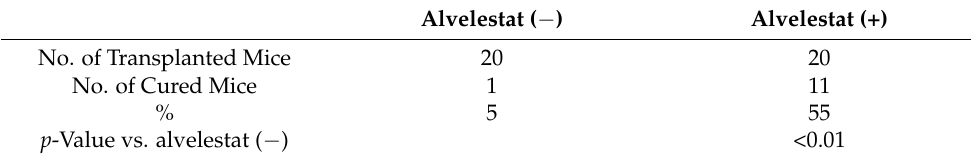
Table 2. In vivo functional assay. Alvelestat ( − ) Alvelestat (+) No. of Transplanted Mice 20 20 No. of Cured Mice 1 11 % 5 55 p -Value vs. alvelestat ( − )